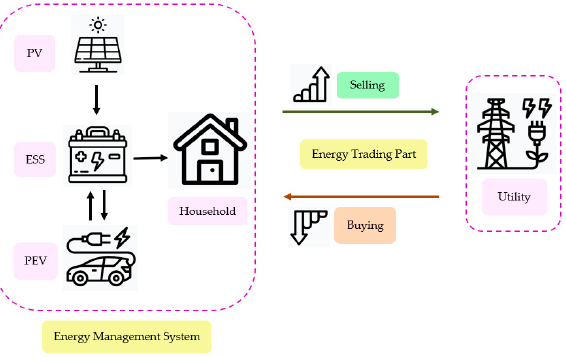
Figure 1. The typical home energy management system (HEMS) model.